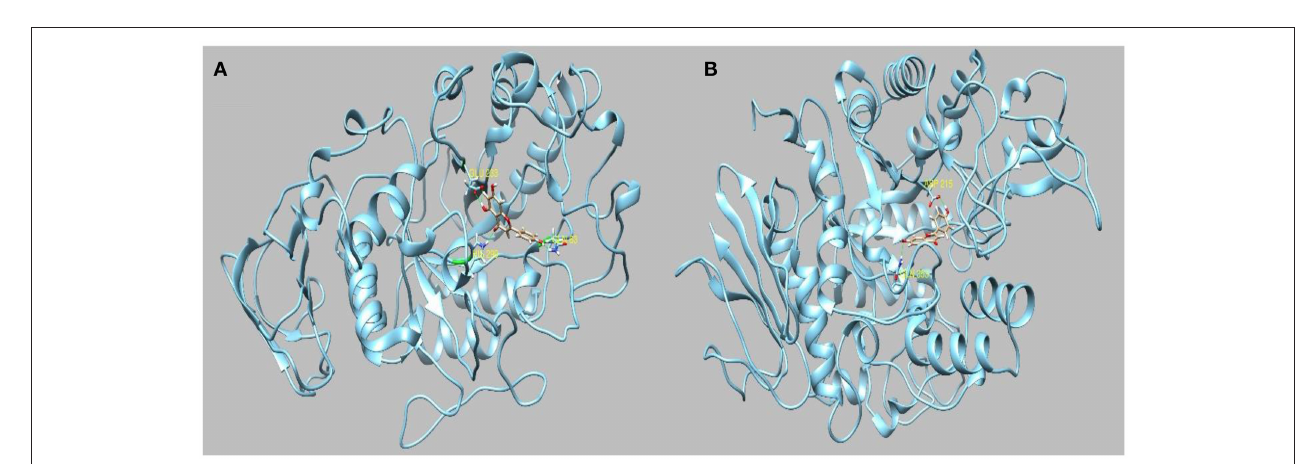
FIGURE 3 | (A) Best pose of apigenin docked to α -amylase and (B) to α -glucosidase.